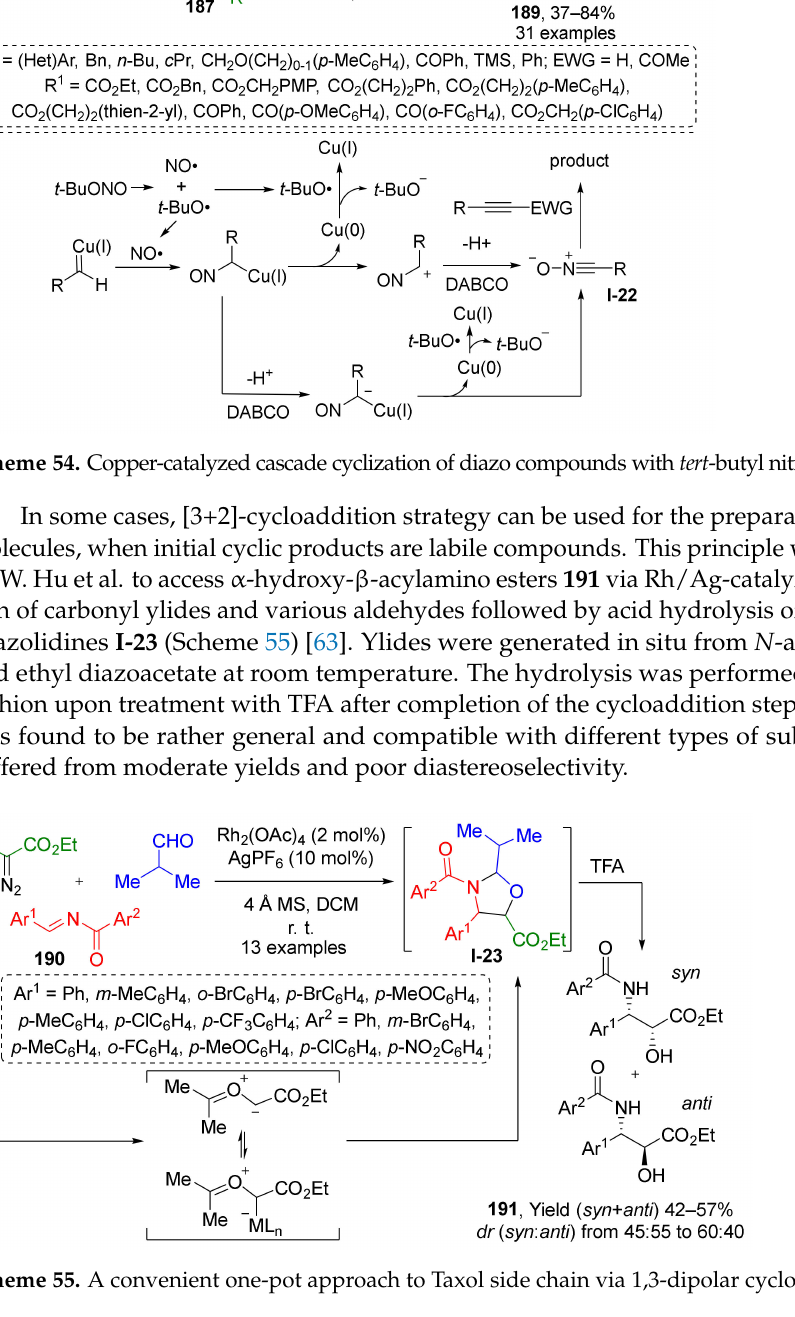
cycloaddition. An MCR based on corresponding reactivity of diazonium cations was used by J.-A. Ma et al. to develop a novel synthetic approach to specifically substituted triazoles (Scheme 56) [64]. In this Cu-catalyzed protocol, α -di- or trifluoro terminal diazo compounds 192 reacted with arene diazonium salts 193 and aliphatic or aromatic nitriles 194 to form N 1 - aryl-1,2,4-triazoles 195 in high yields and moderate regioselectivity. The reaction tolerated a broad scope of substituents, including heterocyclic ones. Mechanistically, it involved generation of dipole from diazo compound and nitrile accompanied by loss of nitrogen molecule followed by cycloaddition with diazonium cation and proton